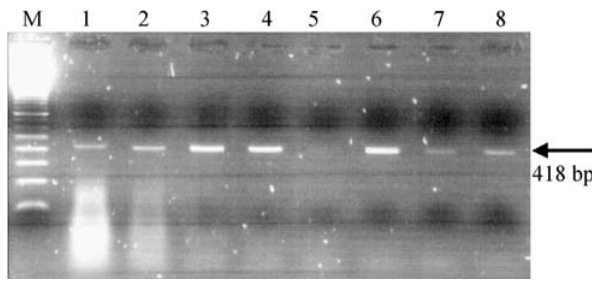
Figure 2 - GH cDNA amplicons separated by 1.5% agarose gel electro- phoresis. Lane M: 100-bp DNA molecular weight markers; Lanes 1-8: RT-PCR products using 1000 ng, 500 ng, 250 ng, 125 ng, 62.5 ng, 31.25 ng, 15.625 ng, and 7.8125 ng of total RNA as template. The 418-bp band represents the GH mRNA.